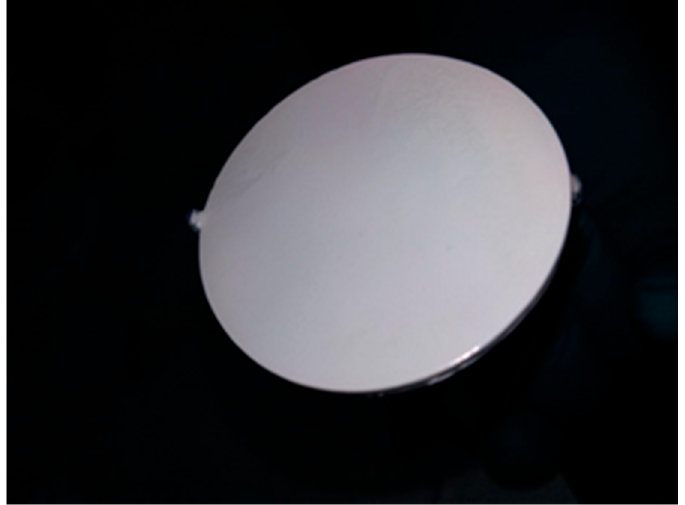
Figure 8. Photo image of disk-shaped α -Al 2 O 3 ceramic substrate (courtesy of MIRTEC, Greece).